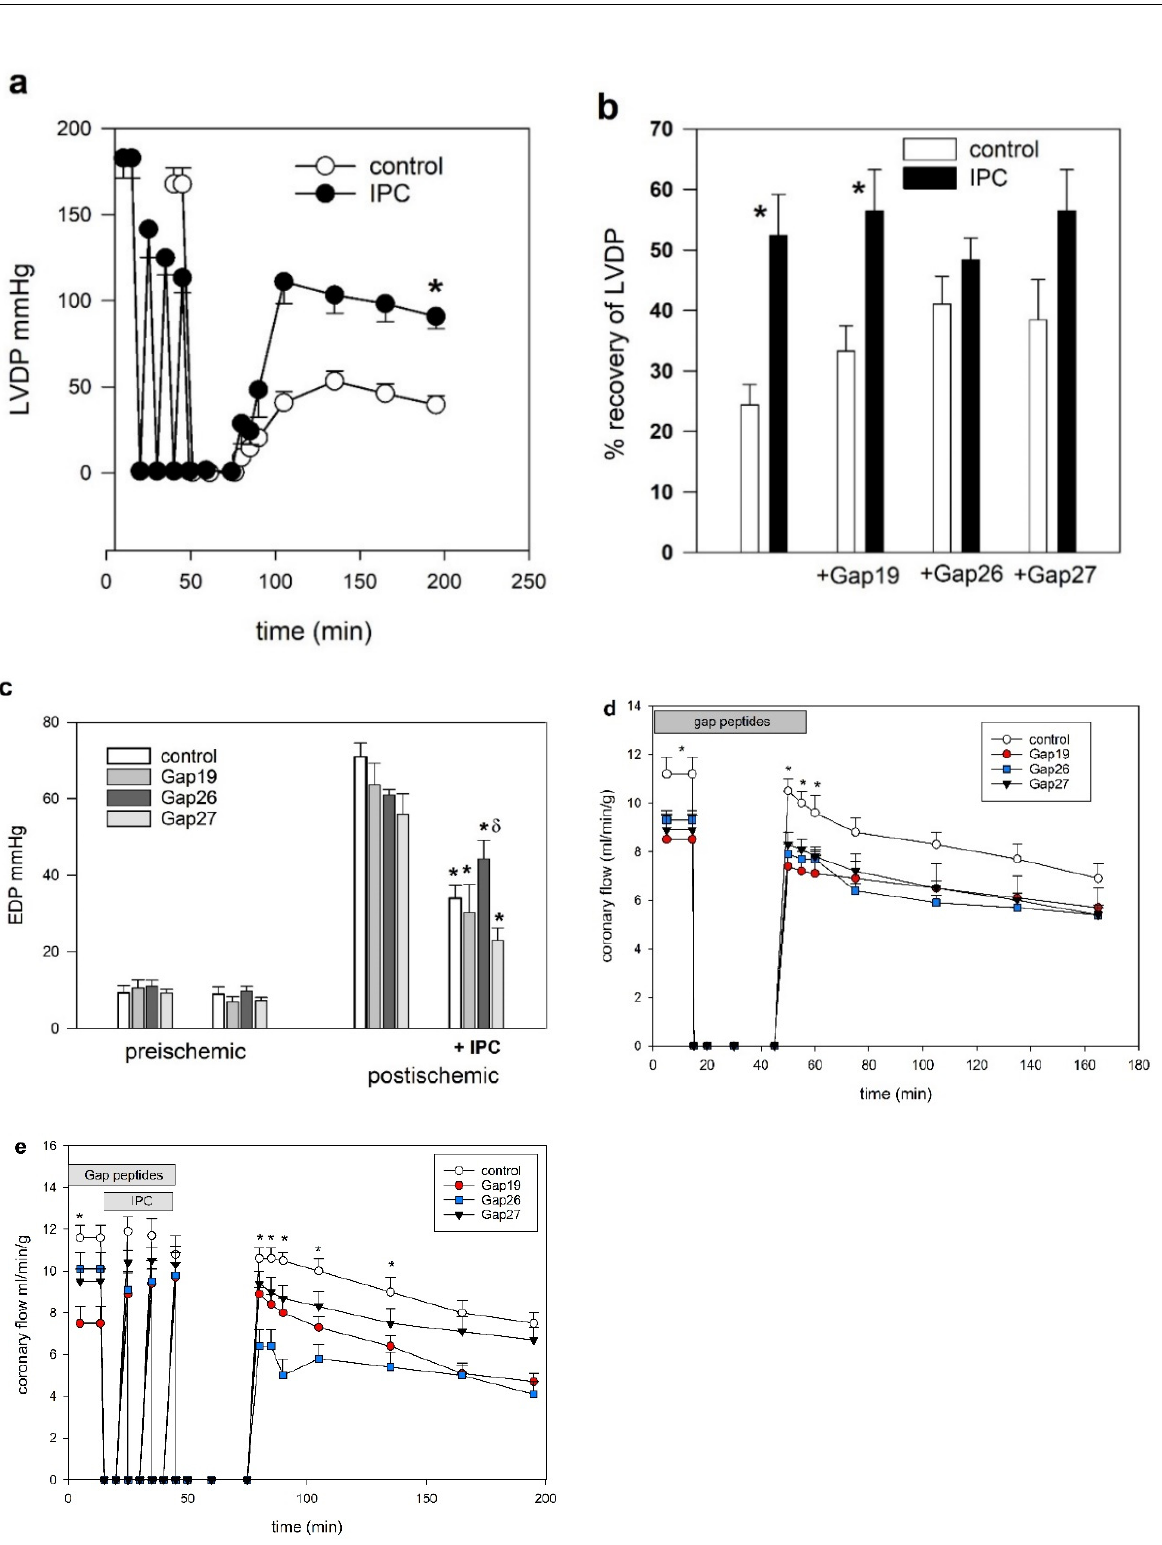
Figure 2. ( a – c ) Heart function in isolated hearts subjected to global ischemia followed by reperfusion with or without IPC and/or Gap peptide treatment: ( a ) Left ventricle developed pressure (LVDP) in control hearts (closed symbols) and hearts subjected to ischemic preconditioning (IPC) (open symbols) followed by 30 min ischemia and 120 min reperfusion * p < 0.05 vs. control. ( b ) Postis- chemic recovery (after 30 min ischemia and 120 min reperfusion) of LVDP as % initial preischemic values. Untreated hearts (controls) and hearts treated with Gap peptides 0.5 uM before and after 30 min ischemia are shown as open bars. Ischemic preconditioning (IPC) treated hearts are shown